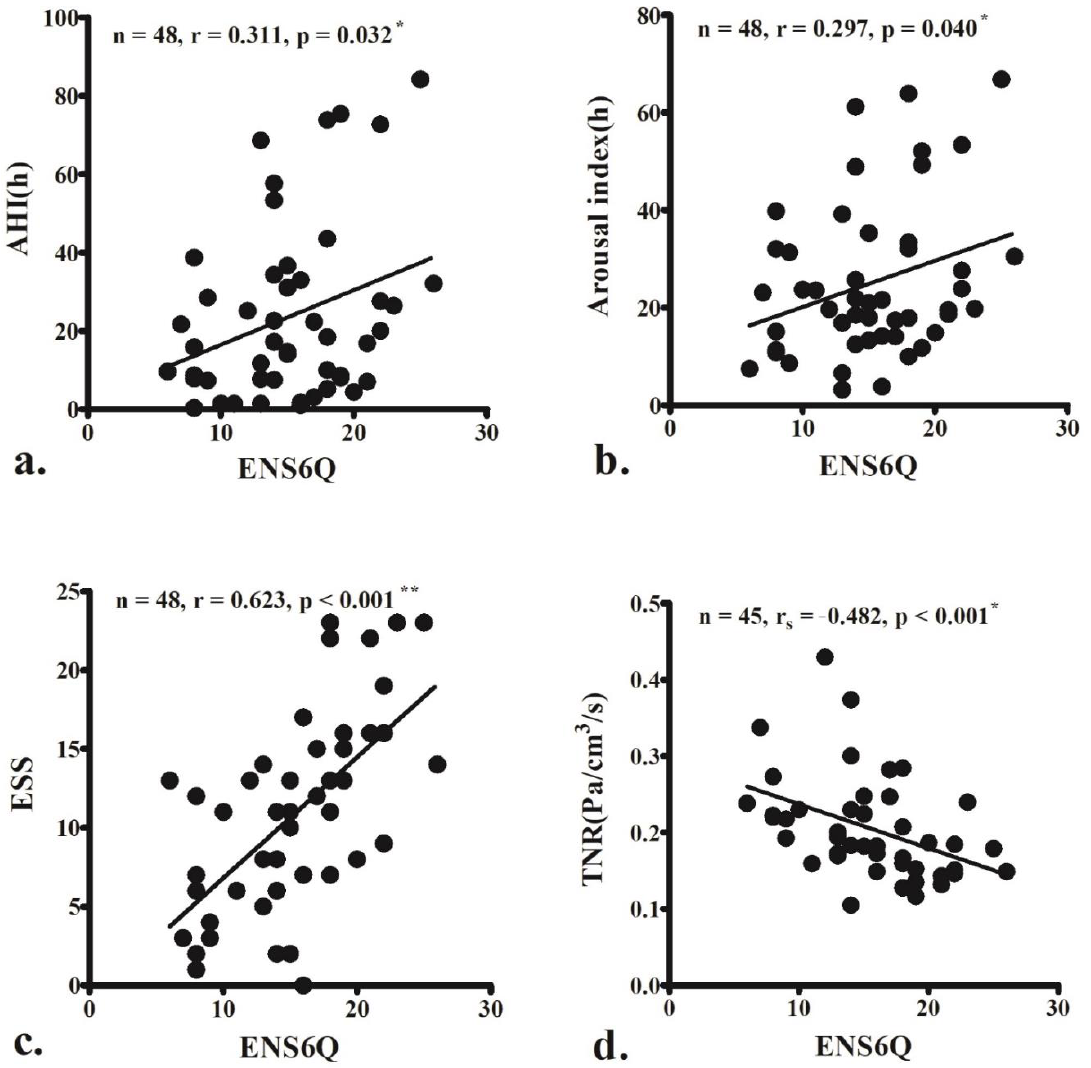
Figure 1. The empty nose syndrome 6-item questionnaire (ENS6Q) scores are significantly associated with the apnoea–hypopnoea index (AHI) ( a ), arousal index ( b ), and Epworth Sleepiness Scale (ESS) score ( c ). ENS6Q is also negatively correlated with total nasal resistance (TNR) ( d ). The correlations were determined using Pearson’s correlation coefficient (r) or Spearman’s correlation coefficient (r s ) if the data did not pass the normality test. (r, 0–0.2: very weak, 0.2–0.4: weak, 0.4–0.6: moderate, 0.6–0.8: strong, 0.8–1.0: very strong correlation) * p < 0.05, ** p < 0.001.